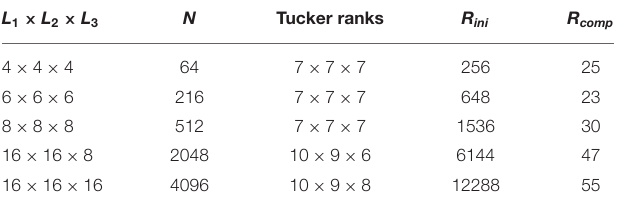
TABLE 3 | Reduced scanonical ranks for the case of functional